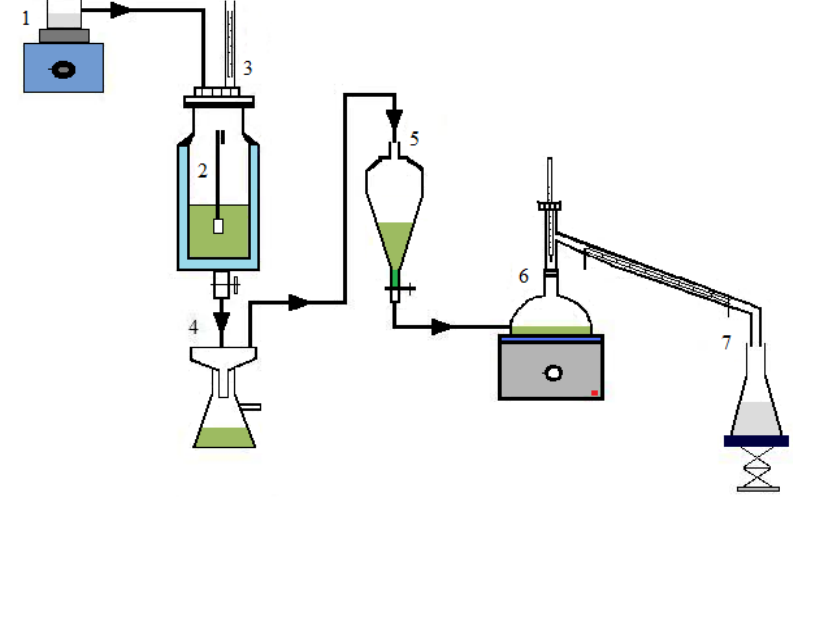
Figure 2. Scheme of the global process: 1. solution of sodium hydroxide in